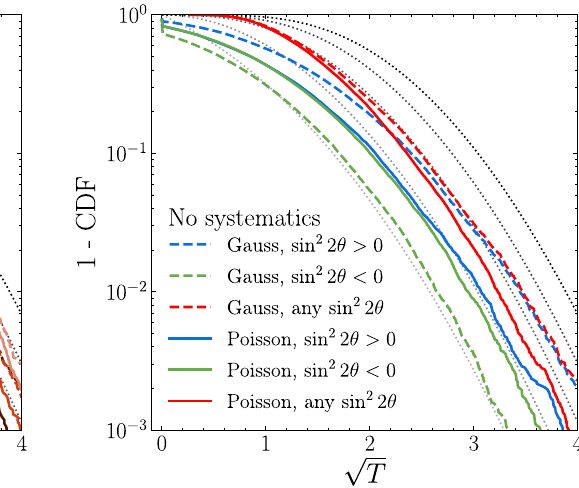
√ Fig. 4 Impact on the distribution of T due to the choice of the χ 2 the results by imposing different restrictions on the allowed range for sin 2 2 θ , as indicatedby the labels.In allcases, atotalof 1 . 5 × 10 4 events implementation. Solid curves correspond to a Poisson χ 2 , while dashed lines correspond to a Gauss χ 2 . The left panel shows the effect of are simulated for each pseudo-experiment. Dotted curves indicate the χ 2 distribution for 1 to 5 DOF from left to increasing the systematic uncertainties from no systematics to an over- all 10% signal normalization uncertainty. In the right panel we show